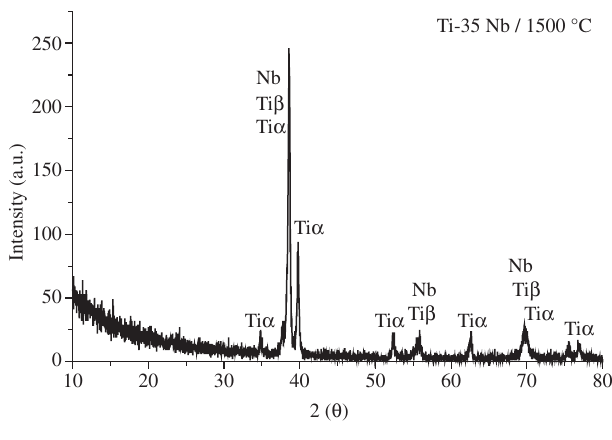
Figure 3. X-ray diffraction pattern of Ti-35Nb alloy spectra after sintering at 1500 °C.